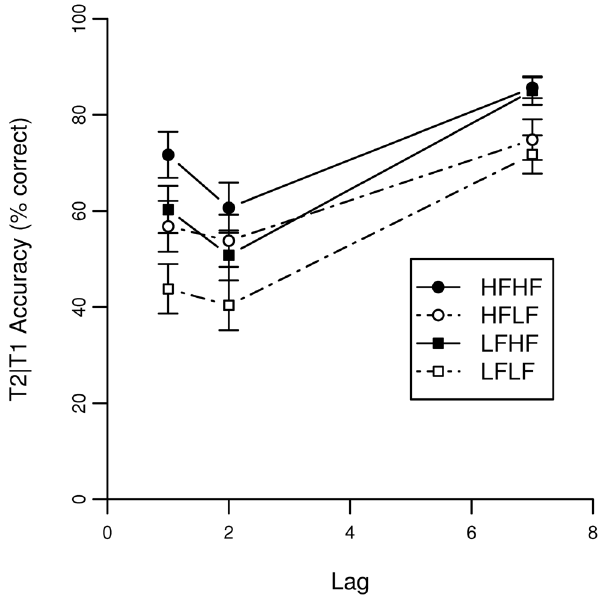
Figure 2. Accuracy scores of the AB task on lag 1, 2 and 7 for T2 given T1 correct in Experiment 1. The lag corresponds to the temporal location of T2 relative to T1.